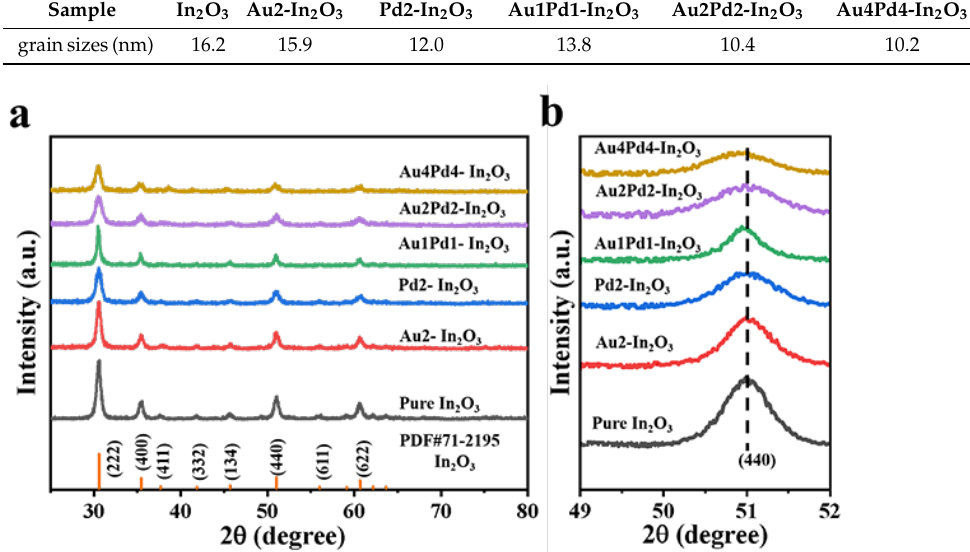
Figure 2. ( a ) XRD patterns and ( b ) high resolution of (440) peak of all the obtained samples. SEM images of the as-obtained samples demonstrate that the solo Au modification can cause the nanofibers to be obviously rougher (Figure 3c,d), while PdO modification cannot change the surface morphology significantly (Figure 3e,f) compared with pure